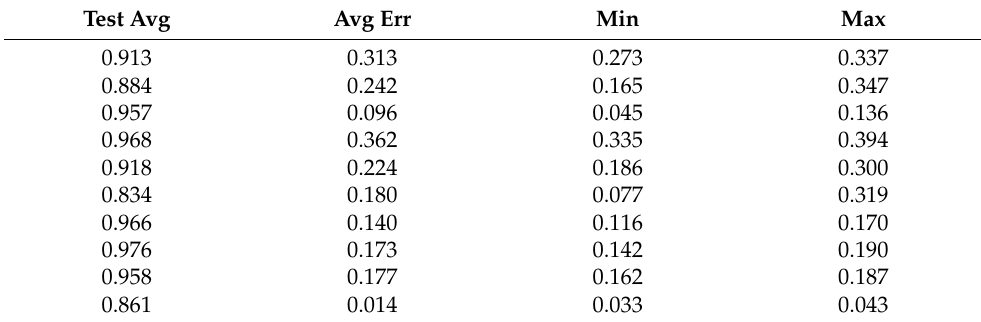
Table A102. Set 2, trials 11–20 data (average actual PR values).